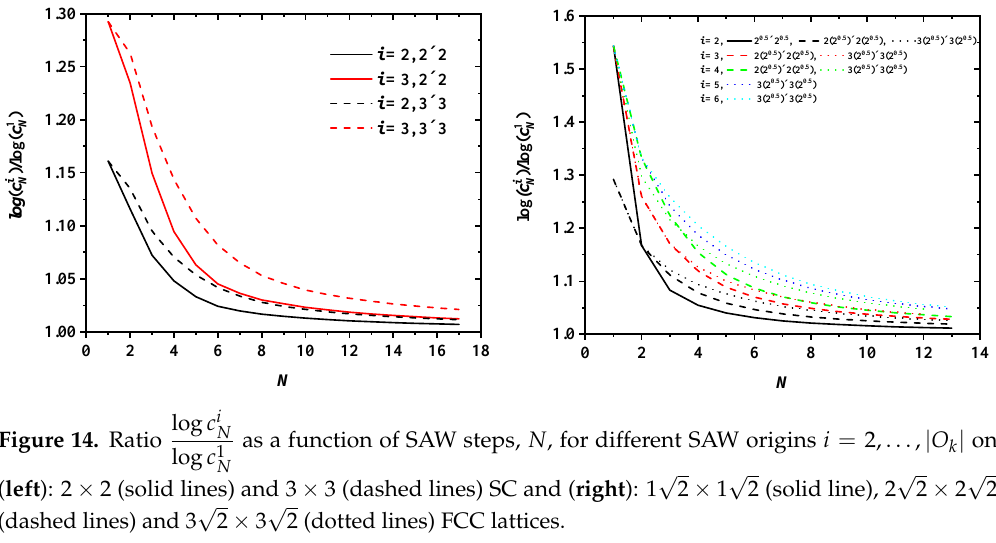
√ √ 2 × 1 2 (solid line), 2